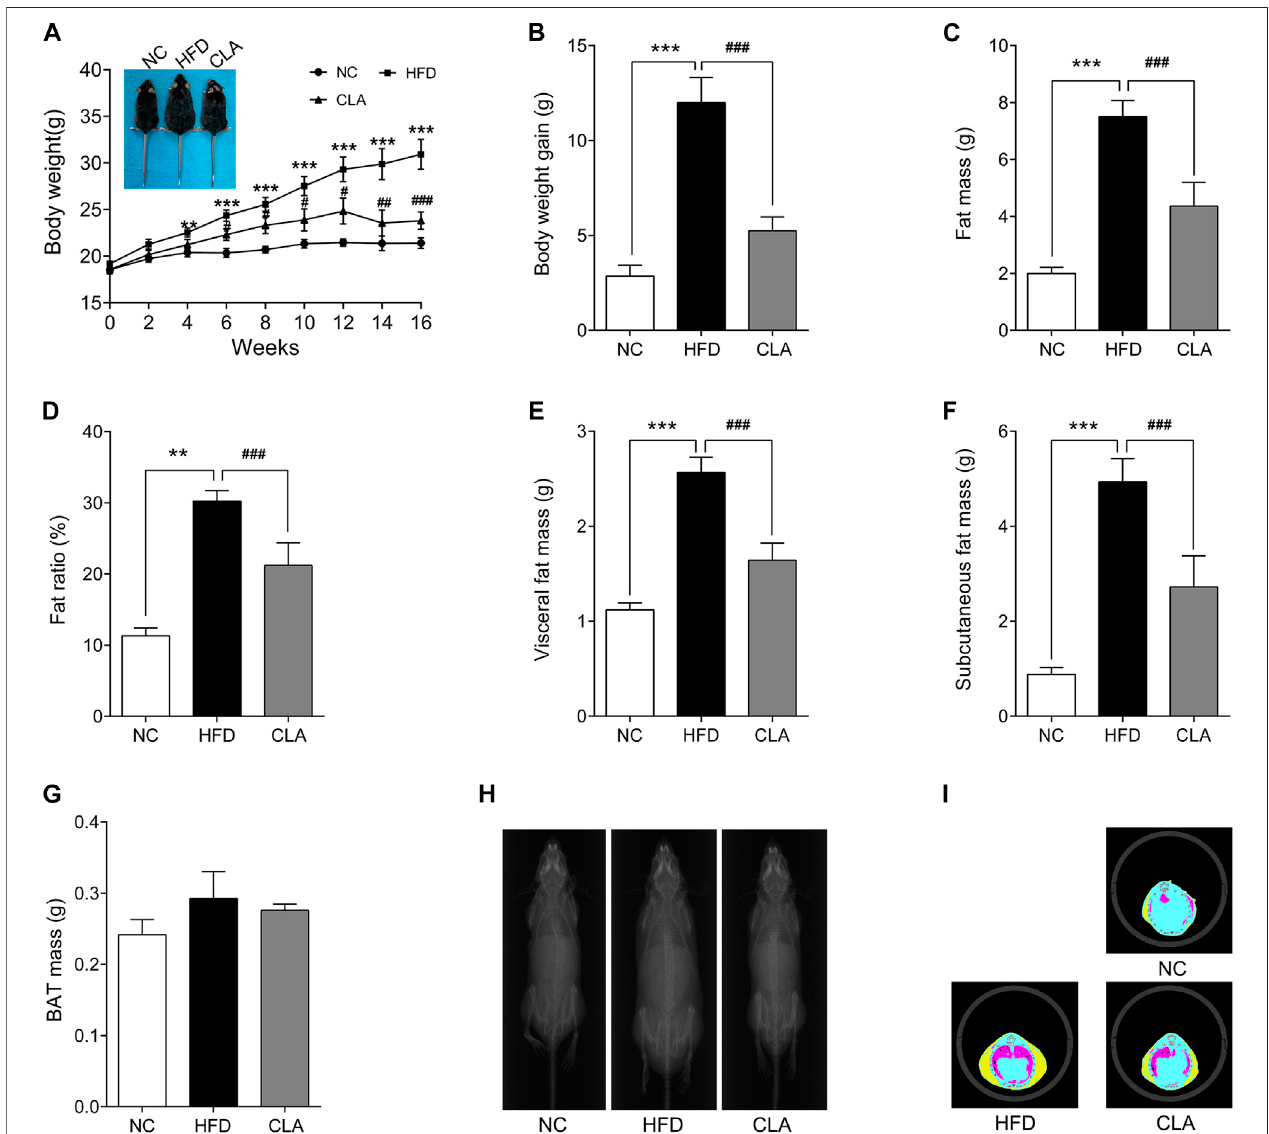
FIGURE1| EffectofcajanolactoneA(CLA)onhigh-fat-diet(HFD)-inducedobesityinfemaleC57BJ/6mice.Micewererandomlydividedintothreegroupsandfeda regular diet (NC group), high-fat diet (HFD group), or high-fat diet combined with CLA treatment (CLA group) for 16 weeks. Body weights (A) were recorded biweekly, and body weight gains (B) were calculated at the end of the experiment. Body composition, including the fat mass of the whole body (C) , fat ratio (D) (Fat ratio % (cid:2) Fat mass/body weight × 100%), visceral fat mass (E) , subcutaneous fat mass (F) and BAT mass (G) , X-ray portraits of the mice (H) , and tomographic images of the mice (I) (yellow: subcutaneous fat; red: visceral fat; blue: lean) were obtained on a Latheta LCT-200 Micro CT (Hitachi Aloka, Tokyo, Japan). Data are shown as the mean ± SEM (n (cid:2) 8). ** p < 0.01, *** p < 0.001 vs. NC. # p < 0.05, ## p < 0.01, ### p < 0.001 vs. HFD.